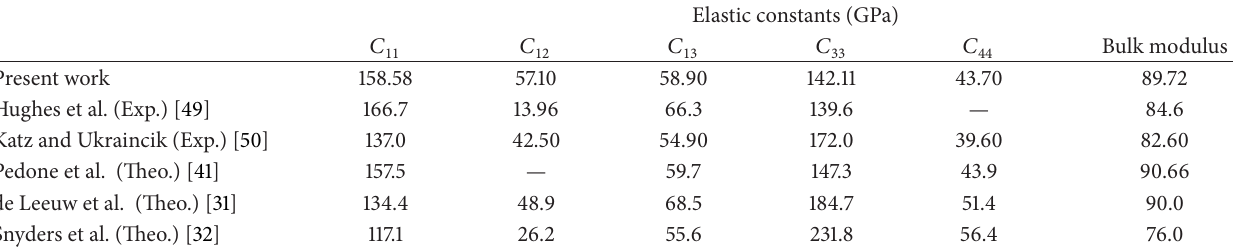
Table 3: Calculated and experimental elastic constants of